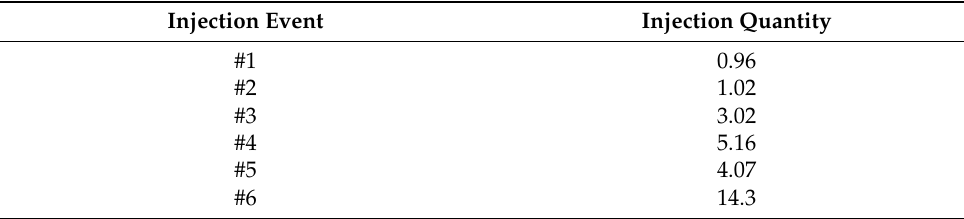
Figure 5. Injection rate profile of the MSS injection strategy. Table 5. Injection quantity for each MSS injection